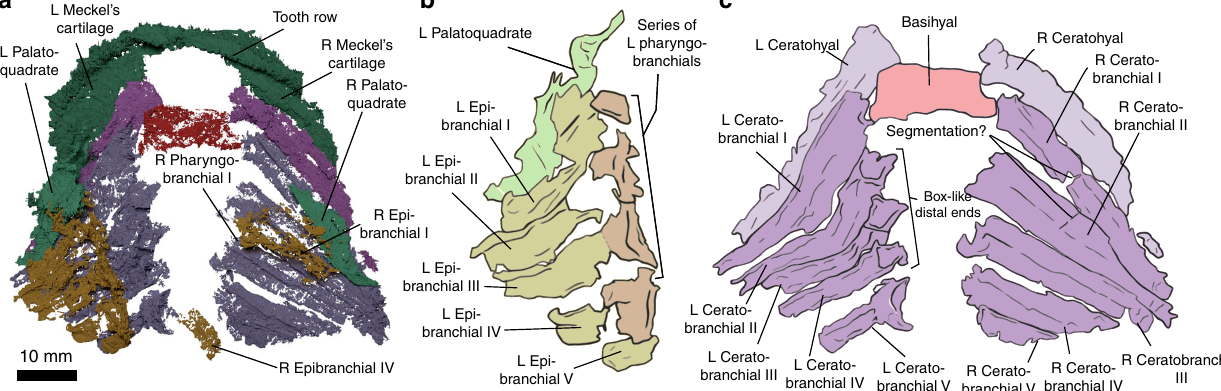
Fig. 2 The pharyngeal skeleton of Ptomacanthus anglicus . a Virtual rendering in dorsal view. b Drawing of dorsal branchial skeleton from the anatomical left hand side. c Drawing of ventral branchial skeleton. Colour scheme: red, basihyal/branchial; purple, ceratohyal (light shade)/branchial (dark shade); yellow, epibranchial; orange, pharyngohyal/branchial; green, mandibular